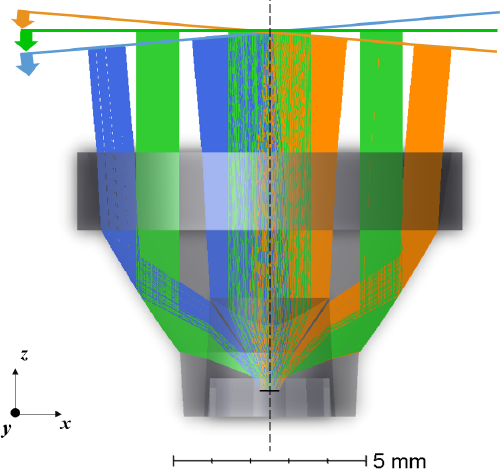
Figure 1. Cross-sectional concept render of the TIR lens and the PD. The colors indicate angles of incidence (blue: − 5°, green: 0°, orange: +5°). Only rays that hit the PD chip are shown.